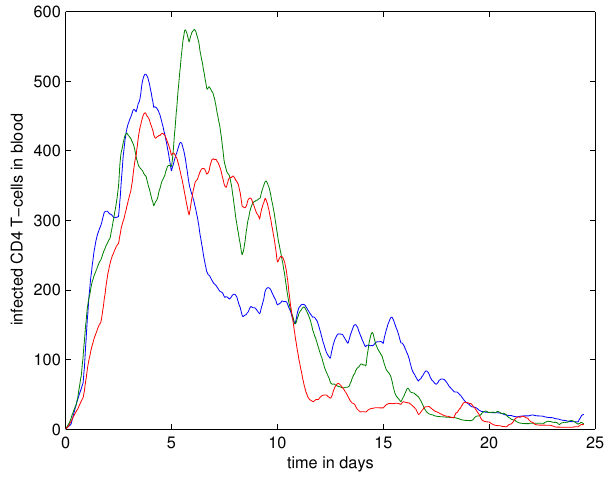
Figure 16. Three single runs of the model from the same starting conditions showing the effect of randomness on the dynamics of infected CD4 + T cells in blood (cell/ µ